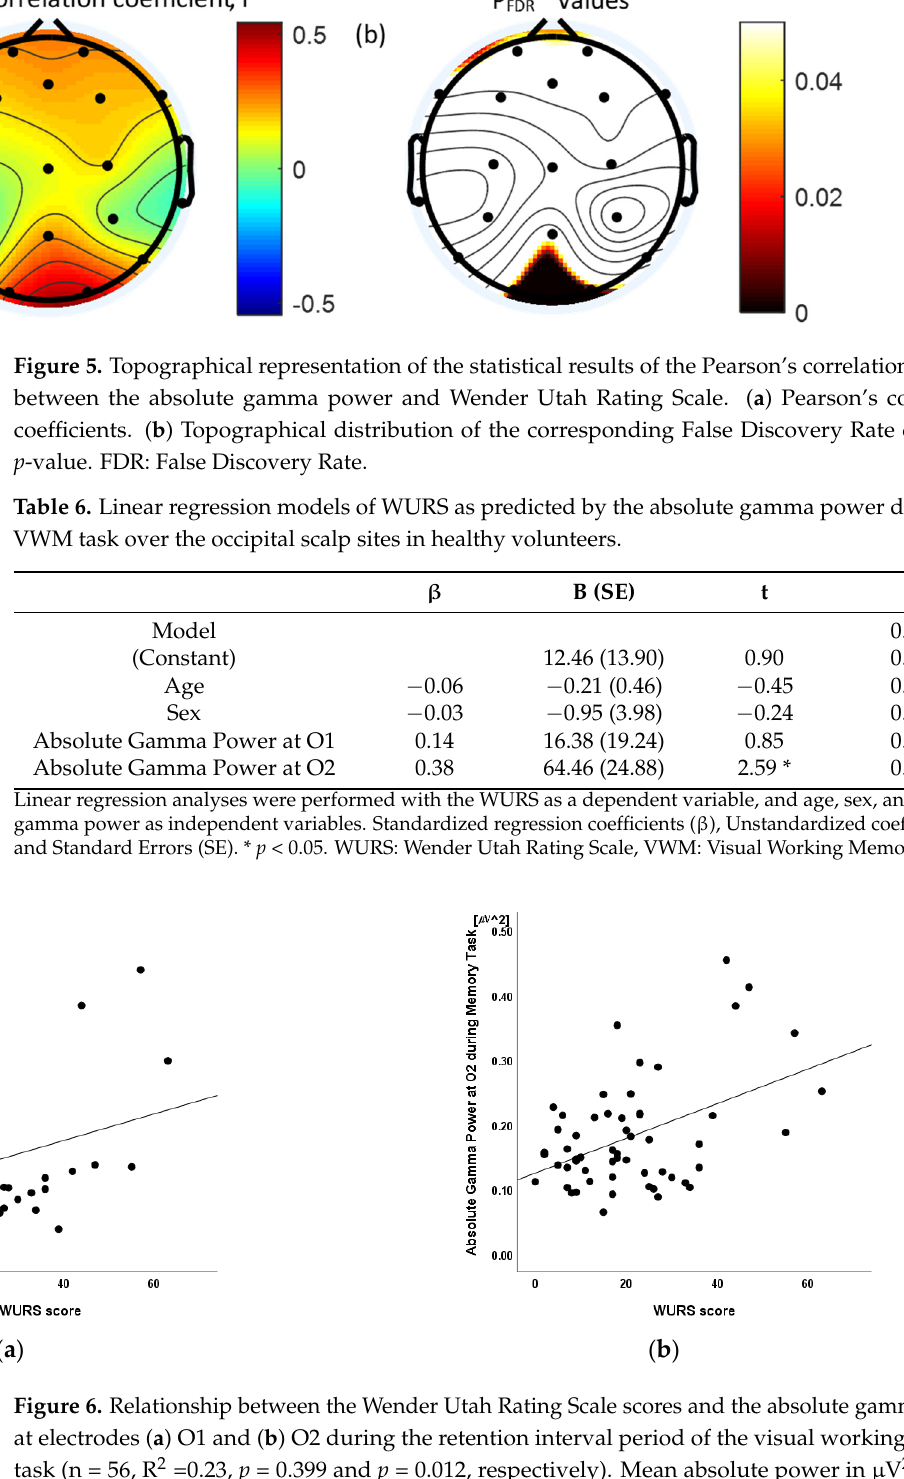
Figure 5. Topographical representation of the statistical results of the Pearson’s correlation analysis between the absolute gamma power and Wender Utah Rating Scale. ( a ) Pearson’s correlation coef- ficients. ( b ) Topographical distribution of the corresponding False Discovery Rate corrected p -value. FDR: False Discovery Rate.